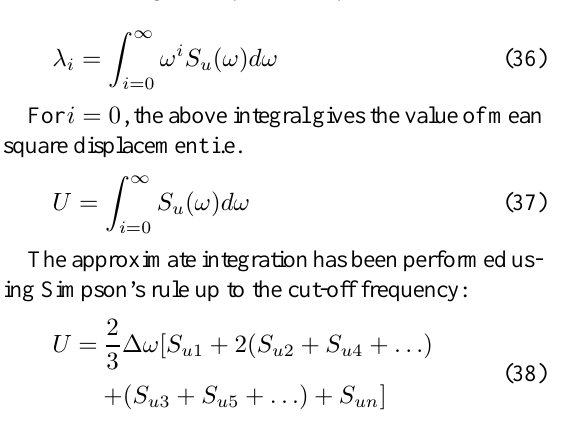
Fig. 7. Comparison of expected value of rms deflection at node 46 with varying c.o.v. of uncertain